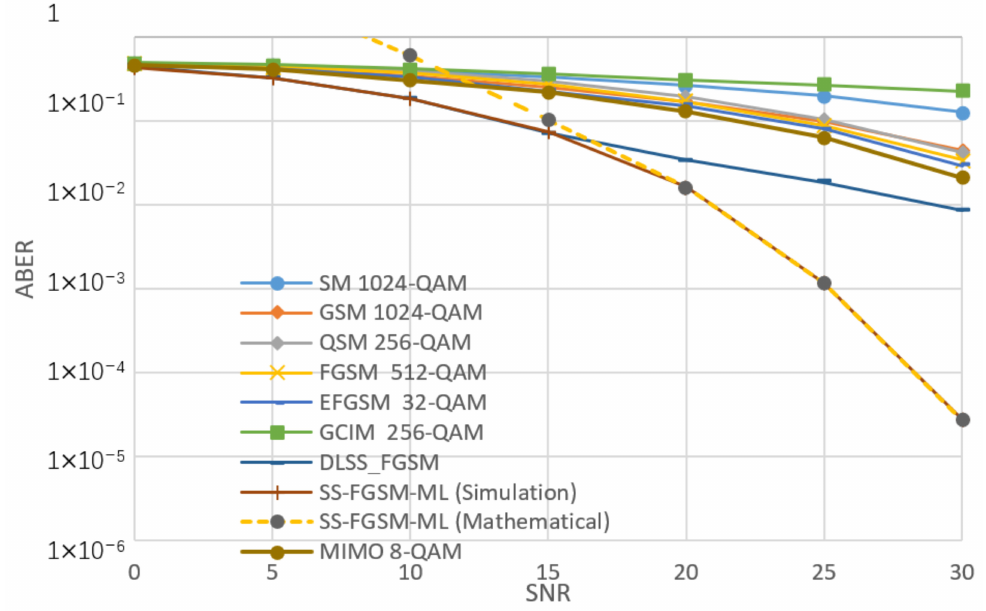
Figure 8. The performance of ABER of proposed SS-FGSM and conventional SMTs at 12 bpcu